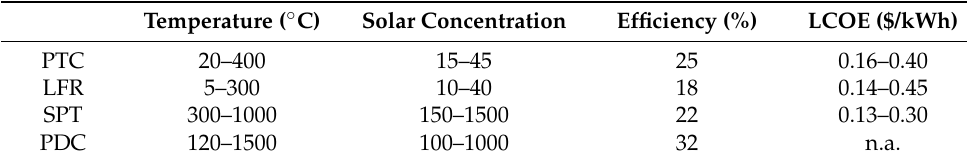
Table 1. Performance metrics of CSP technologies